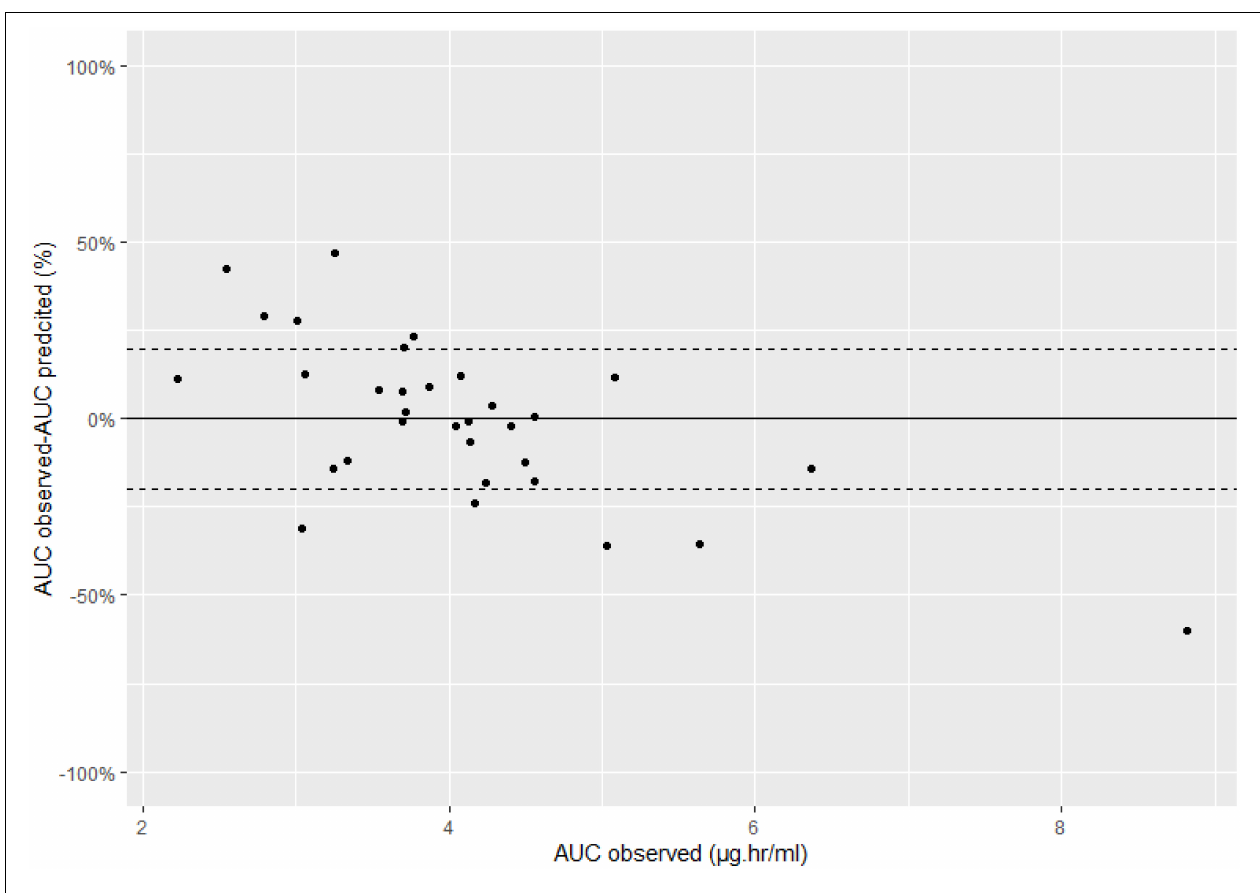
FIGURE 2 | Bland-Altman plots, dashed lines represent